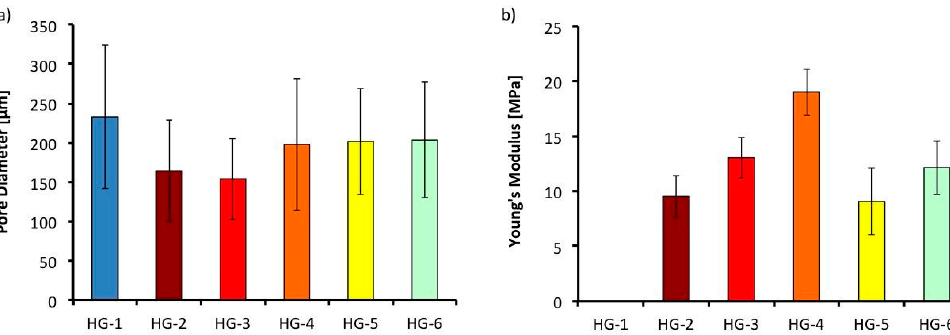
Figure 6. ( a ) Average pore size of the different hydrogels obtained from SEM images ( b ) Young’s Modulus of the different hydrogels obtained from tensile test in the Universal machine.